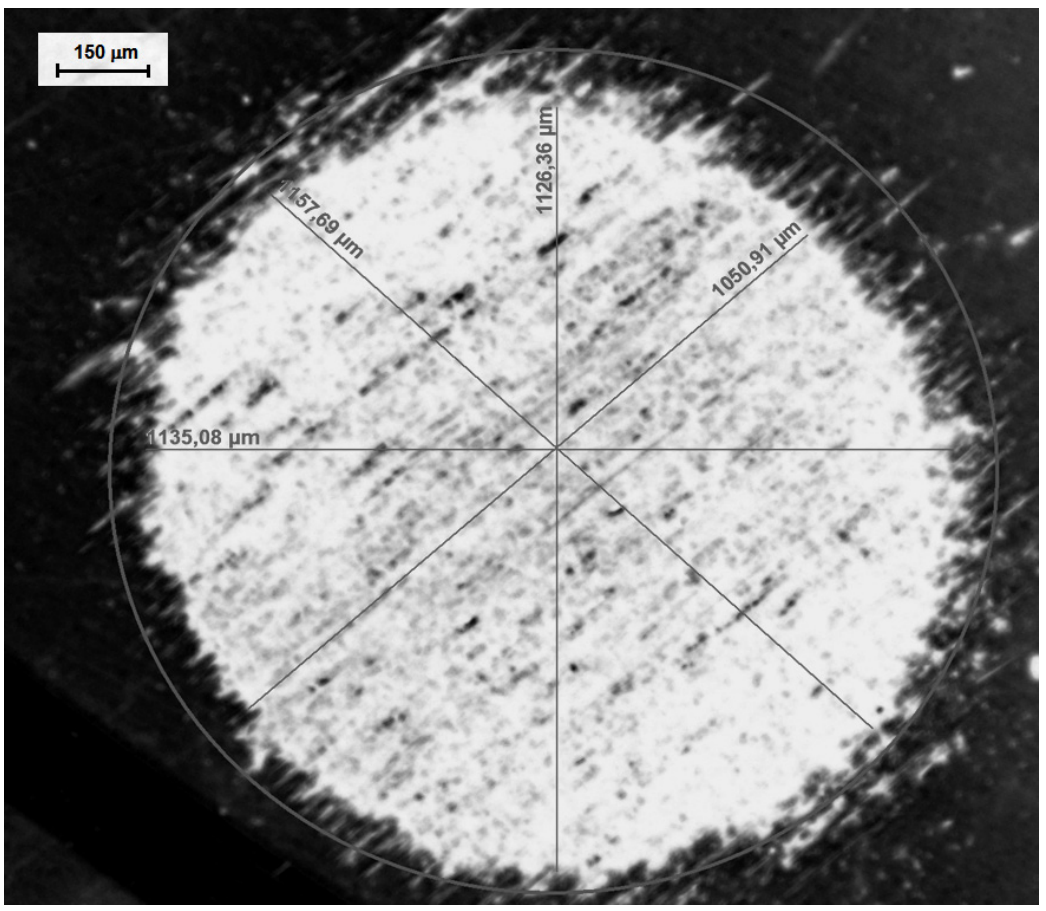
Figure 6. Crater produced in DLC-coated steel sample by optical microscopy. The crater edge has grooves in which became difficult the diameters measurements.